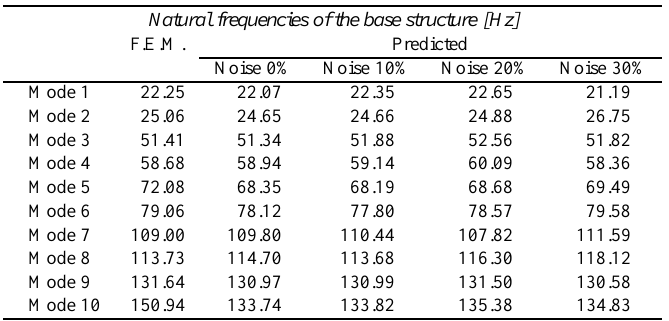
Table 5 Identified vs. predicted natural frequencies of the coupled structure Natural frequencies of the base structure [Hz]